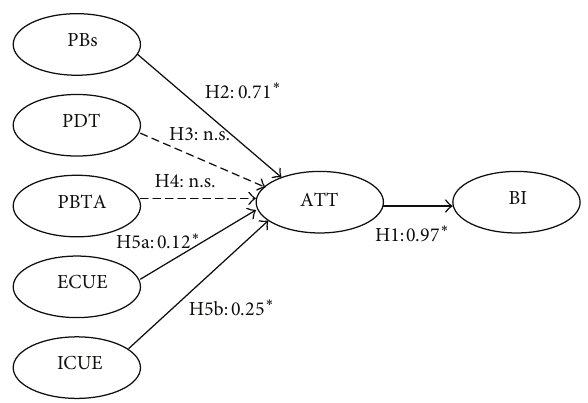
Figure 2: The results of structural model. Note: perceived benefits (PBs), perceived disease threat (PDT), perceived barriers of taking action (PBTA), external cues to action (ECUE), internal cues to action (ICUE), attitude toward using (ATT), behavioral intention to use (BI). ∗ Path coefficient is significant at the 0.05 level. n.s. insignificant at the 0.05 level (path coefficient is obtained from this